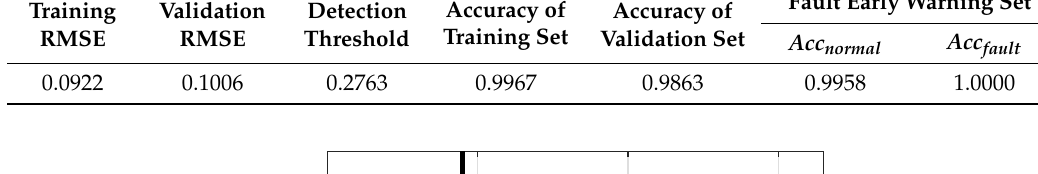
Figure 17. Residual distribution in validation set.